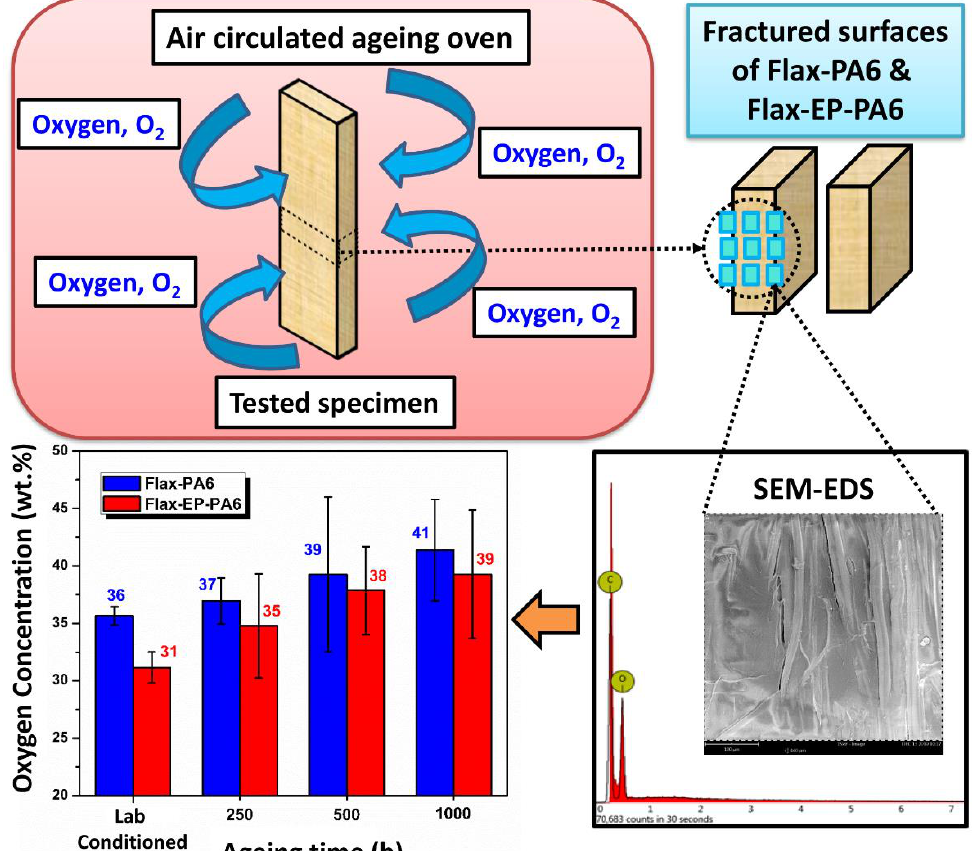
Figure 10. Schematic diagram of tested samples in ageing oven and oxygen concentration analyzed with scanning electron microscopy–energy-dispersive X-ray spectroscopy (SEM–EDS) at the outer layer of the aged biocomposite specimens.